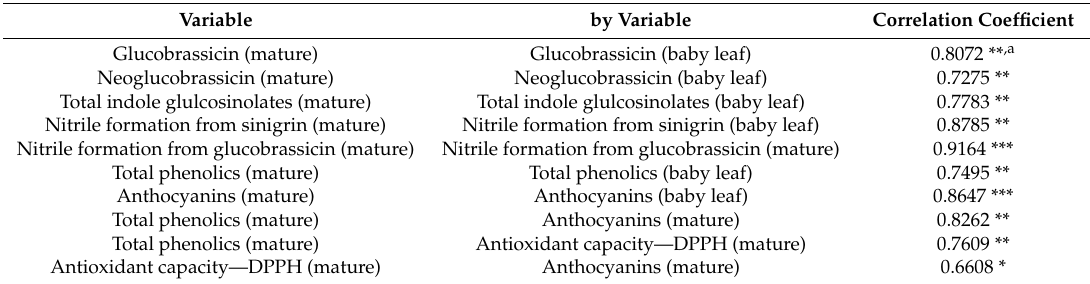
Table 1. Selected significant correlation coefficients for phytochemical concentration and antioxidant capacity of 11 mustard cultivars.